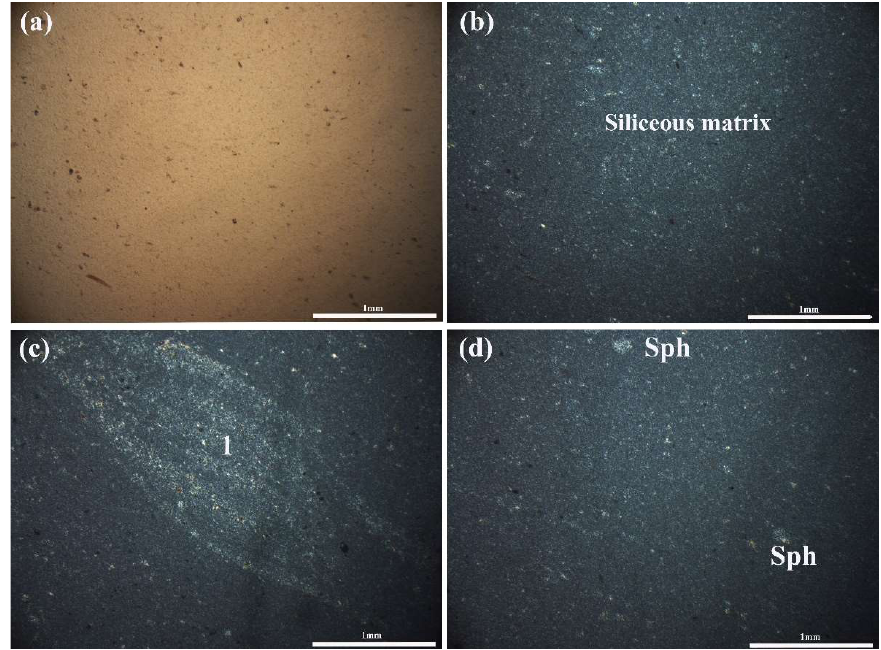
Figure 8. Photomicrographs of MB1b microstructures in ( a ) plane (PPL), and ( b – d ) cross polarized light (XPL) (Sph: spherulite, 1: micritic bioclast replaced by siliceous material).